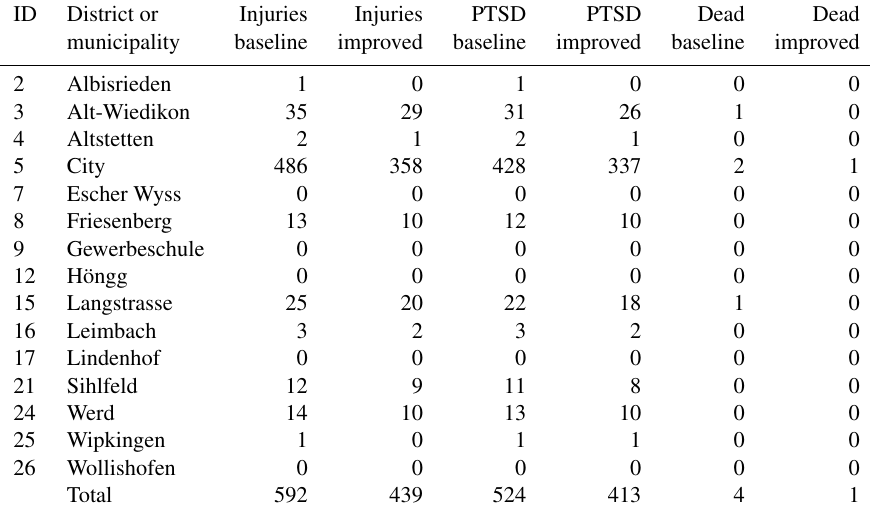
Table 3. Affected human individuals per district or municipality-day flood. Note: only affected districts are